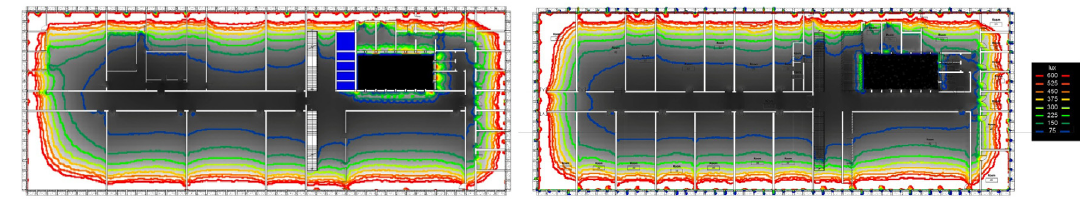
Fig. 6. Daylighting assessment of the Architectural Engineering building (3rd and 5th fl oor plans). Table 1. Glazing characteristic of baseline, Case A and B.